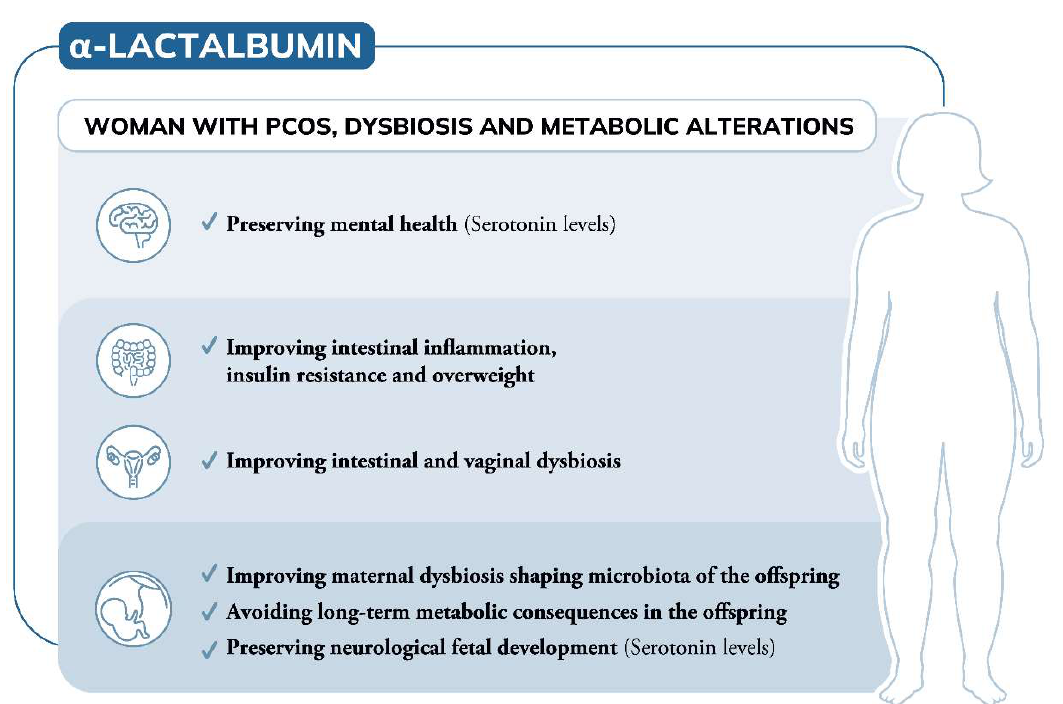
Figure 1. α -Lactalbumin role in the management of women with PCOS, dysbiosis and metabolic alterations . Acting on different aspects, α -Lactalbumin ( α -LA) induces beneficial effects in